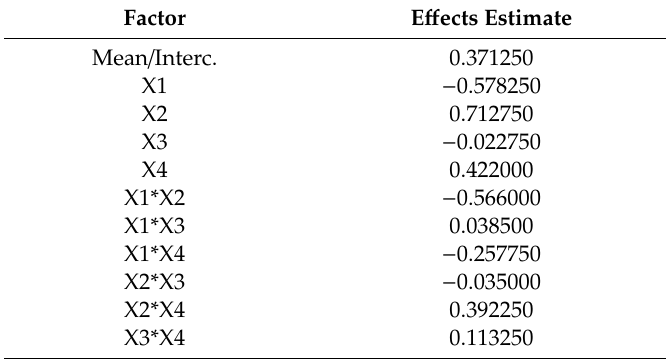
Table 2. E ff ects estimates from each independent variable of the factorial design 2 4 evaluated at 95% of the coe ffi cient limit. Factor E ff ects Estimate Mean / Interc.